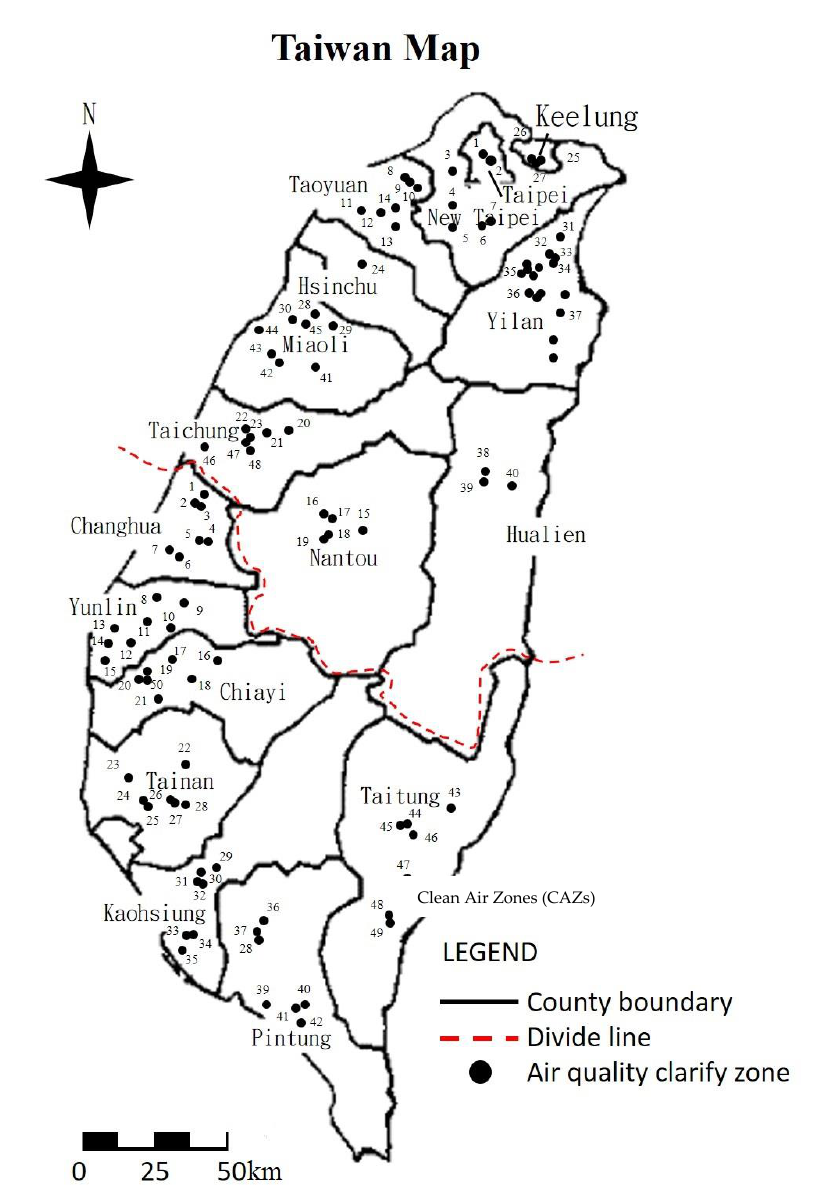
Figure 1. Map of surveyed clean air zones (CAZs).